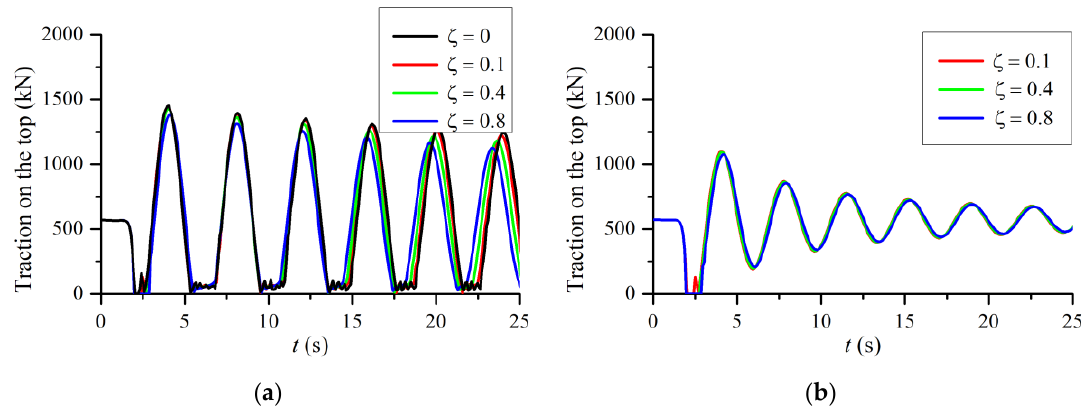
Figure 12. Influence of the structural damping ratio on the snap load of the cable–payload system in 300 m depth, with different drag coefficients ( 𝐶 𝑑,𝑝 ) of the payload: ( a ) 𝐶 𝑑,𝑝 = 0.7; ( b ) 𝐶 𝑑,𝑝 = 7.